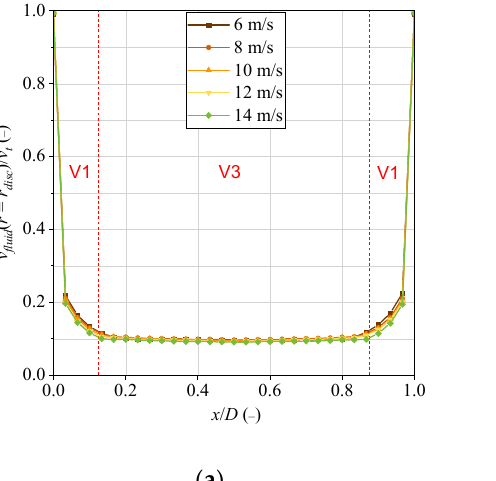
( b ) Figure 10. Average grinding media velocity between the discs at the radius of the disc circumference ( r = 0.36). The red vertical lines show the border between volumes V1 and V3: ( a ) for varied stirrer tip speeds; ( b ) for varied grinding media fillings. 3.3. Stress Energy In the following, the theoretical maximum stress energies occurring during a bead– bead impact are investigated according to their local distribution. Figure 11a,b show the locally averaged stress energies in the axial section. In Figure 11a, the energy resulting from the normal translational impact direction is shown in the logarithmic scale, and in Figure 11b the energy resulting from the translational shear is drawn. The collisions with the highest stress energies can be found close to the stirrer. On average, the collisions with the lowest stress energies took place in the middle between the two stirrer discs. In the